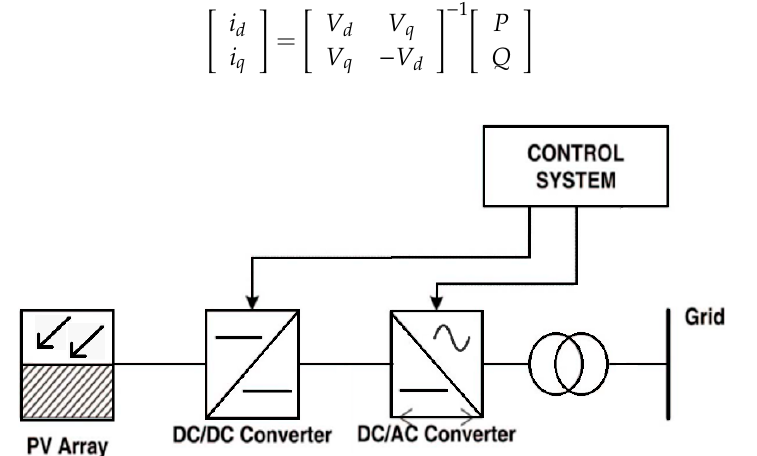
Figure 11. The structure of a grid-connected PE-based DER utilizing solar photovoltaic generator (SPVG).